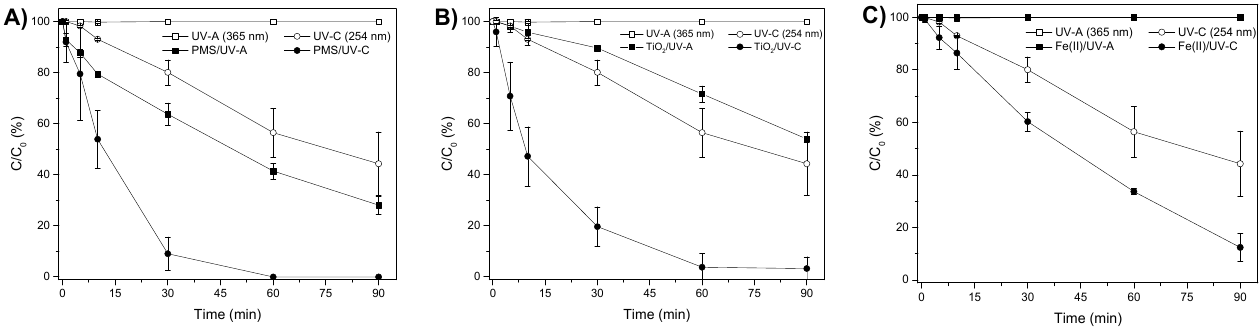
Figure 1. MB discoloration (%) with ( A ) 500 mg/L PMS; ( B ) 500 mg/L TiO 2 ; ( C ) 28 mg/L Fe 2+ ; using UV-A and UV-C radiation.